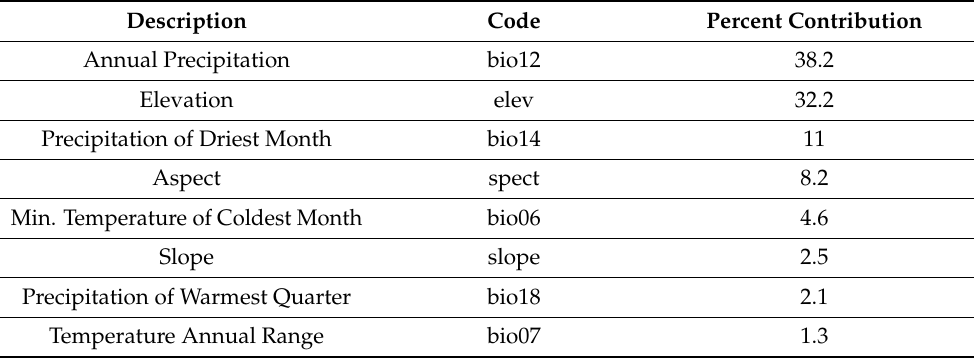
Table 1. Environmental factors selected after preliminary processing and their contribution